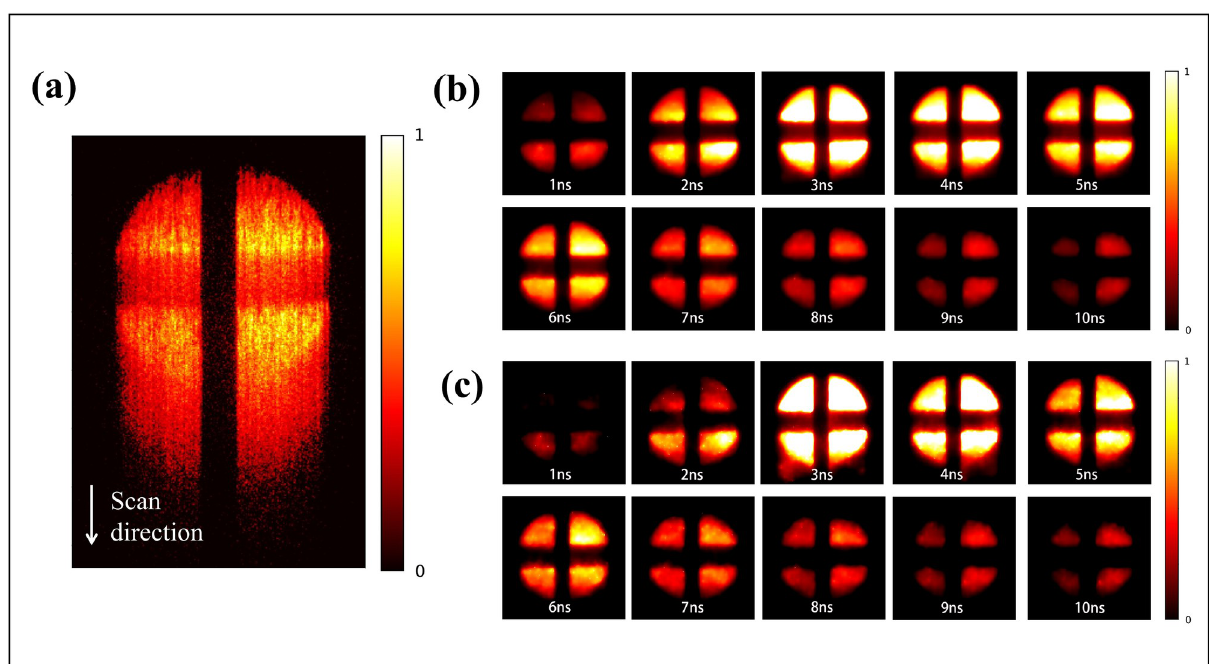
Fig 6. Measurement and reconstruction data of Rhodamine 6G: (a) Streak Camera image; (b) Reconstructed frames using PnP-TV+FFDNet algorithm; (c) Reconstructed frames using PnP-3 DTG p V_net algorithm.